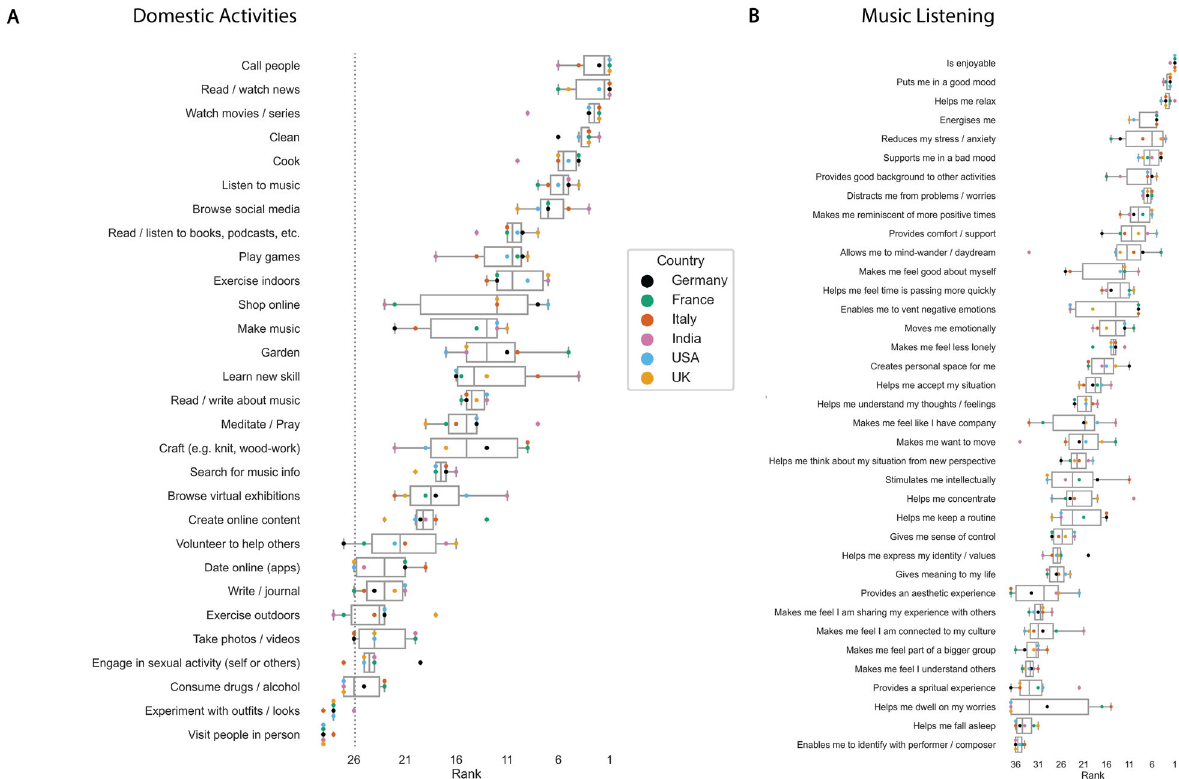
Fig. 1 Ranked domestic activities and functions music listening should serve. A Lockdown activities, n = 4206, and B functions of listening to music, n = 4146, ranked by mean change in importance of each item, within country. Final ranks are displayed according to median rank across all countries. The dotted vertical line in A represents the change point left of which items became less important, on average, across all countries. No vertical line is drawn in B because all items became more important, on average. Box plots represent the dispersion of rankings across countries, for each item. Each dot represents a country. The left and right sides of the boxes represent the 25th and 75th percentiles, with a line at the median. Error bars represent the lowest and highest ranks within a 1.5 interquartile range (IQR). Points falling outside the IQR are de fi ned as